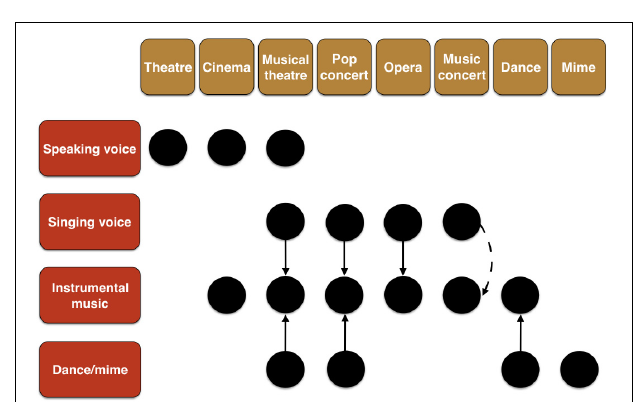
FIGURE 4 | The building blocks of arts combinations in the performing arts. The figure shows eight forms of the performing arts along the top. These are then classified with respect to their inclusion of four performance modalities: speaking voice, singing voice, instrumental music, and dance (and/or mime). Black circles imply the presence of a given modality in a given artform. The vertical arrows indicate the typical directionality of coupling, suggesting that singing and dancing are very often done to the beat of instrumental music in these artforms. The dashed arrow for “music concert” implies that singing can be done either a capella or to instrumental accompaniment; likewise, instrumental music can be performed all on its own. Performance art (not shown here) sits in the categories represented by dance and